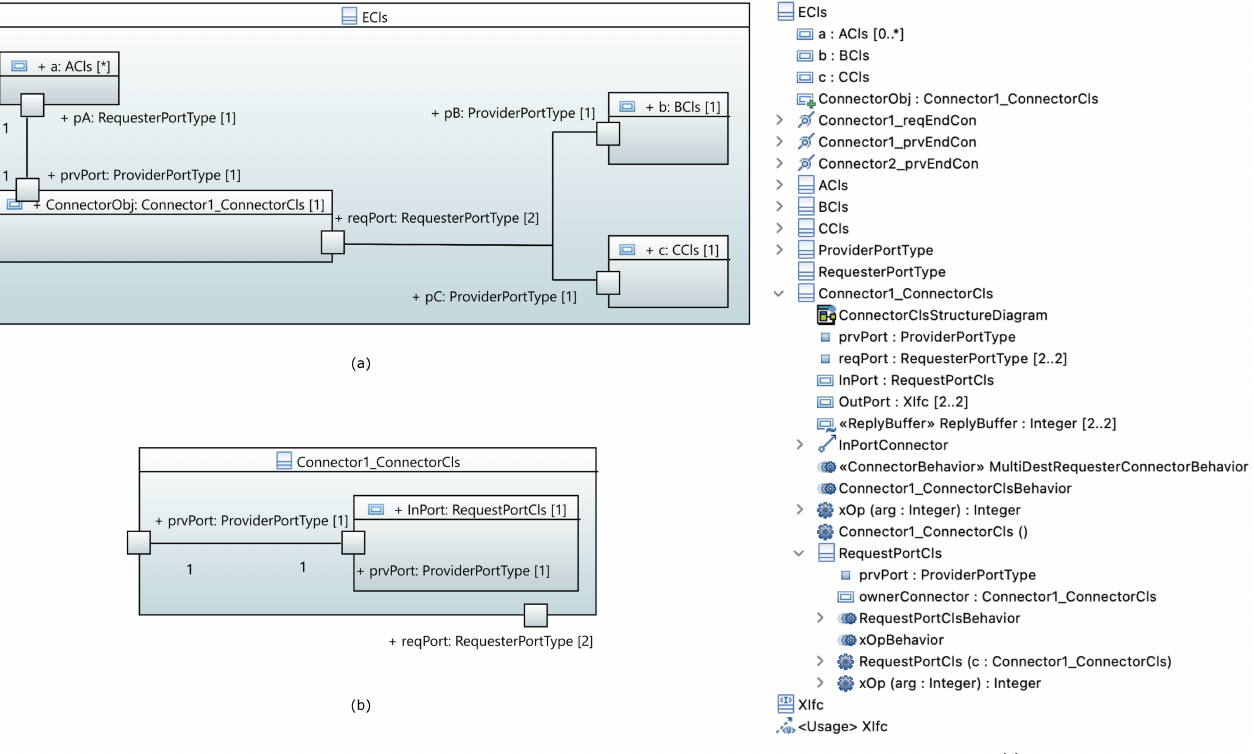
Figure 11. E2 model for the example shown in Figure 8: ( a ) Composite structure diagram that contains the requester, providers, and the object of the connector class. ( b ) Composite structure diagram for the connector class. ( c ) UML model showing the connector behavior and other behaviors generated by the model